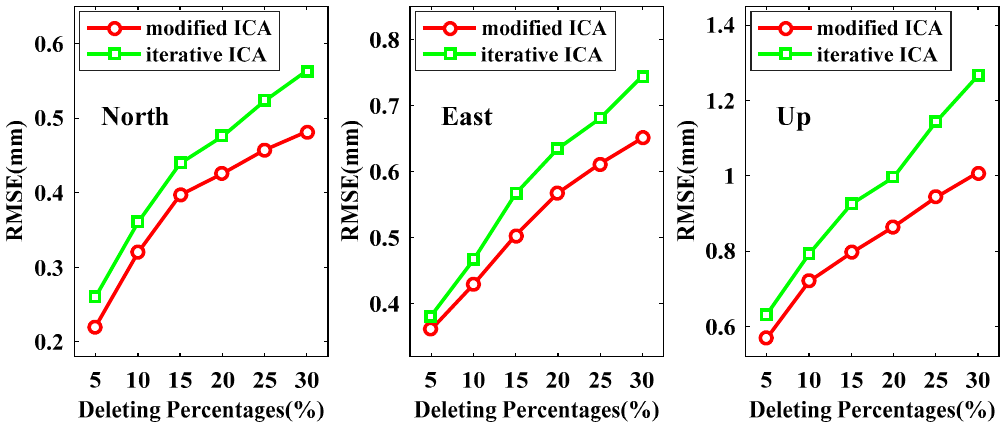
Figure 10. RMSEs of the reconstructed signals derived from modified ICA and iterative ICA at the deleting data points.